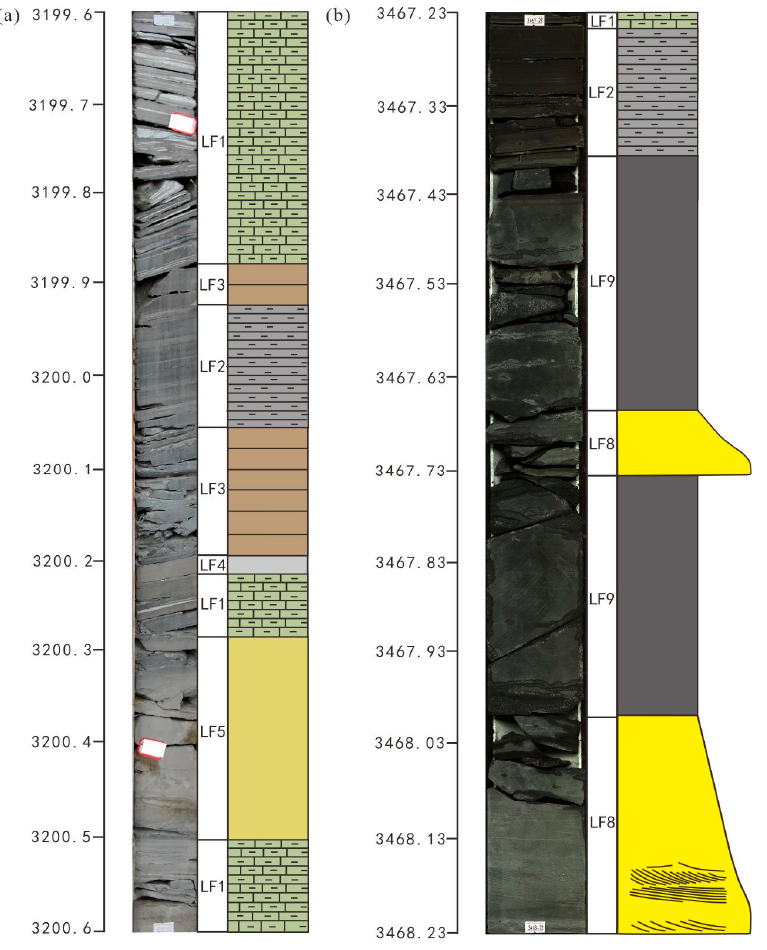
Figure 5. The lithofacies in cores. ( a ) Well NY1, 3199.6–3200.6 m; ( b ) Well NY1, 3467.23–3468.23 m. 4.2.5. Middle-High Organic Massive Calcareous Fine-Grained Sedimentary Rocks (LF5) Middle-high organic massive calcareous fine-grained sedimentary rocks (LF5) are light gray (Figure 3e). The TOC content of them ranges from 2.02 to 8.12 wt% with an average of 3.61 wt%. The average content of clay minerals, quartz and feldspar and carbonate minerals are, respectively, 15.43 wt%, 17.57 wt% and 62.86 wt%. The content of carbonate minerals can be up to 79 wt%. Carbonate minerals also mainly exist as marl and sparry (>20 µ m) grains (Figure 4k). Under the microscope, there are abundant biodetritus and some have been replaced by carbonate minerals (Figure 4k,l). The LF5 only occur locally.